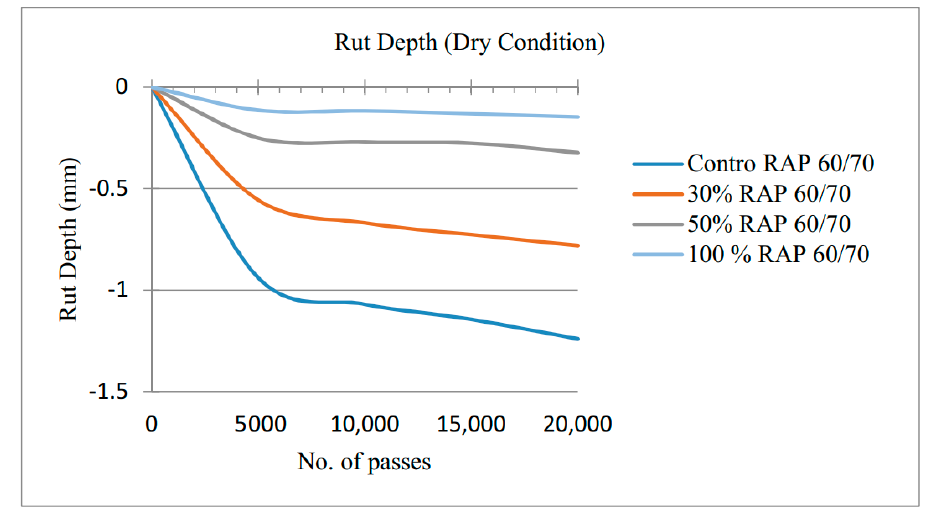
Figure 9. Rut depths under air-dry conditions.